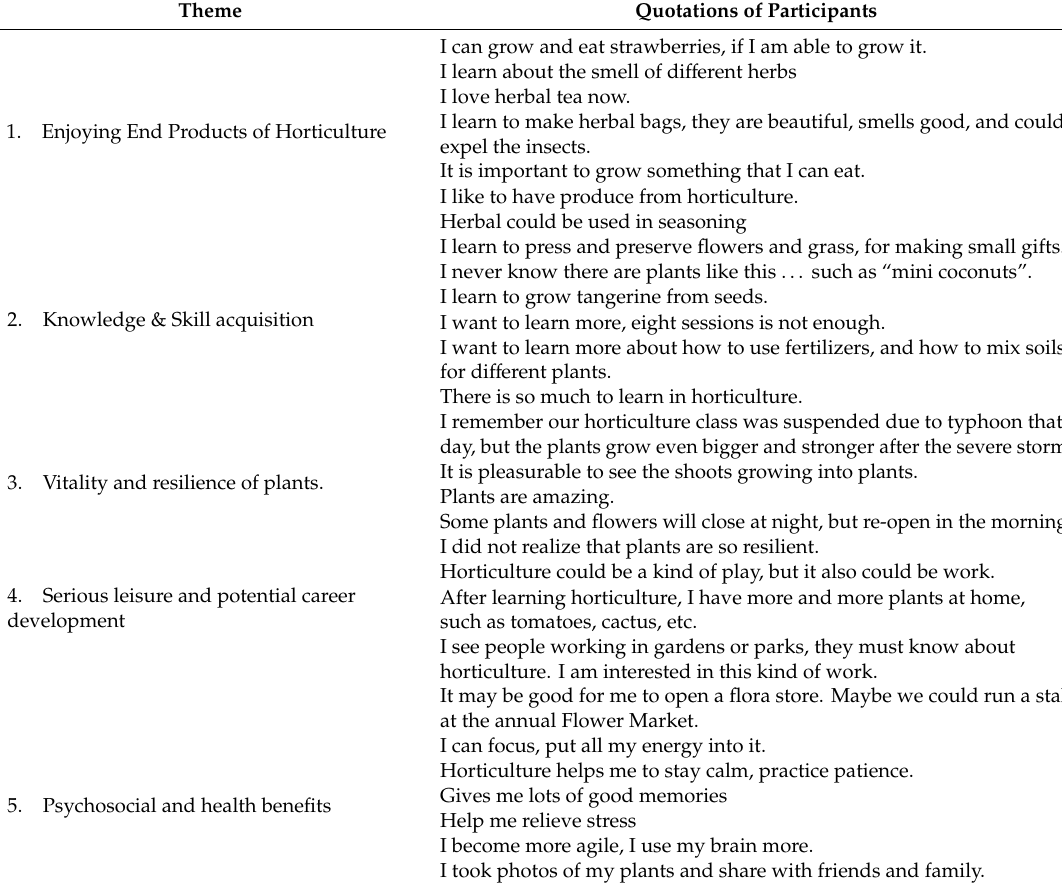
Table 4. Themes identified from analysis of focus group interview, with quotations of